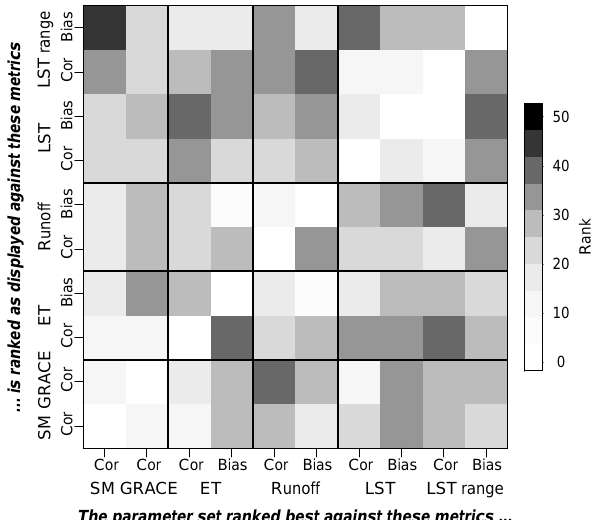
The parameter set ranked best against these metrics ... Figure 3. Performance of HTESSEL simulations with the differ- ent best-performing parameter sets as assessed against all particular metrics, respectively. For example, the HTESSEL simulations with the parameter sets that yield best results in terms of ET bias (see the corresponding column) also perform well in terms of runoff bias (white colour) but not in terms of ET correlation (dark